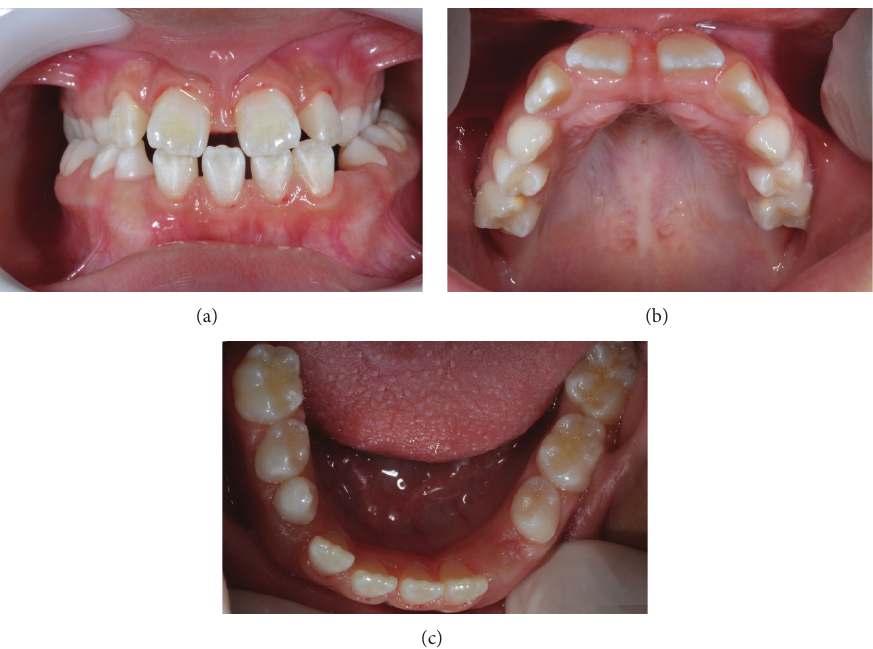
Figure 1: Intraoral photographs. (a) Front view; (b) maxillary arch; (c) mandibular arch.